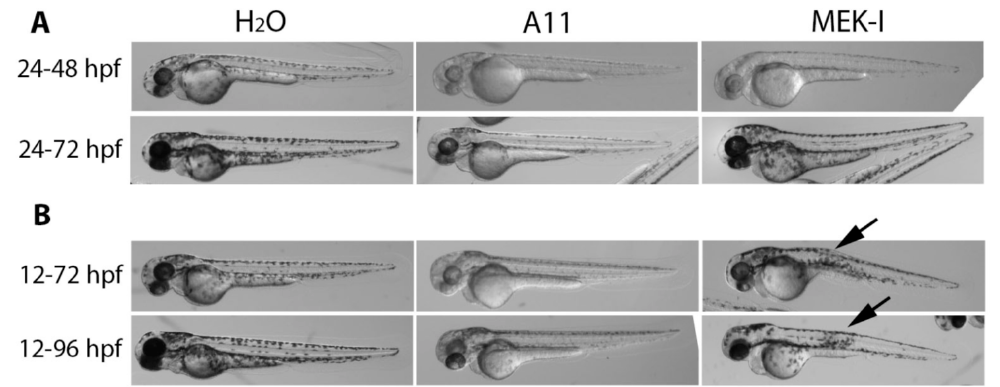
Figure 2. Differential pharmacodynamics of A11 and MEK-I. ( A ) Embryos were treated with A11 or MEK-I for different lengths of time. A11 maintained fairly strong pigment inhibition from 24–48 hpf to 24–72 hpf while MEK-I apparently lost its potency in the 24–72 hpf embryo, compared to the MEK-I 24–48 hpf embryo; ( B ) When embryos were treated from 12 hpf for 3–4 days, A11 still maintained strong pigment inhibition but MEK-I did not show any inhibition in the 12–72 or 12–96 hpf embryos. Arrows point to the notochord defects caused by MEK-I.